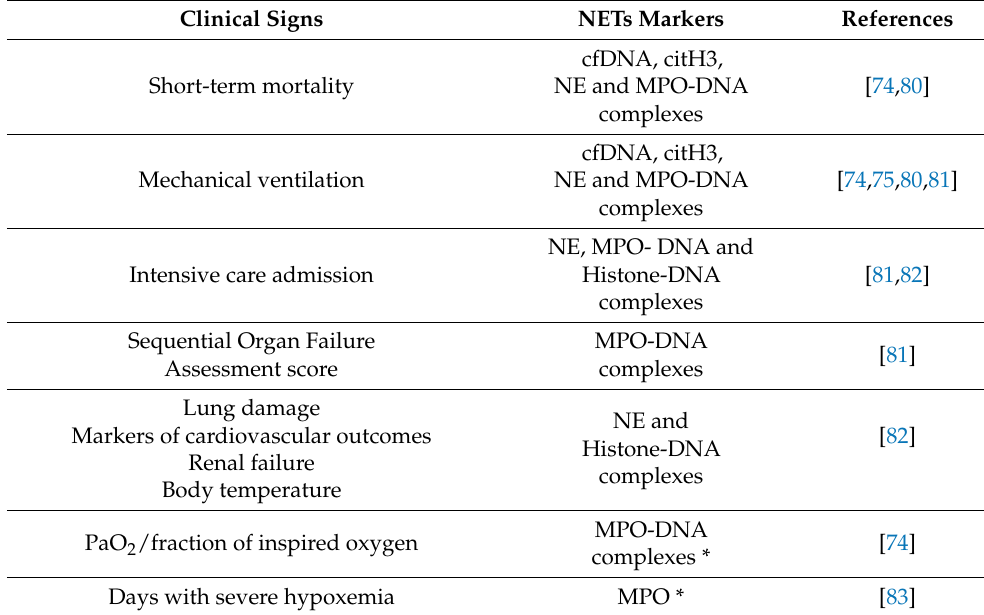
Table 1. Clinical signs associated with levels of different markers of neutrophil extracellular traps (NETs). Clinical Signs NETs